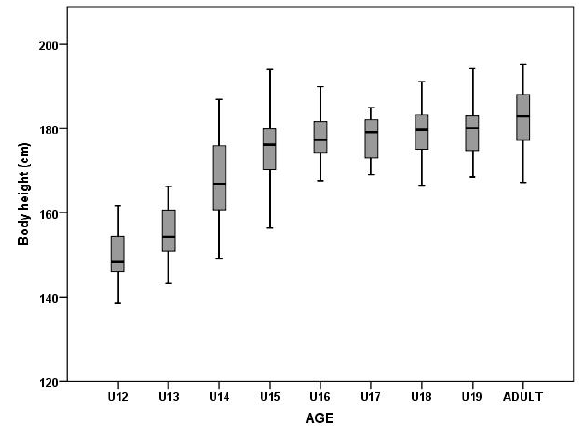
Figure 1. Differences in body height among different age groups.